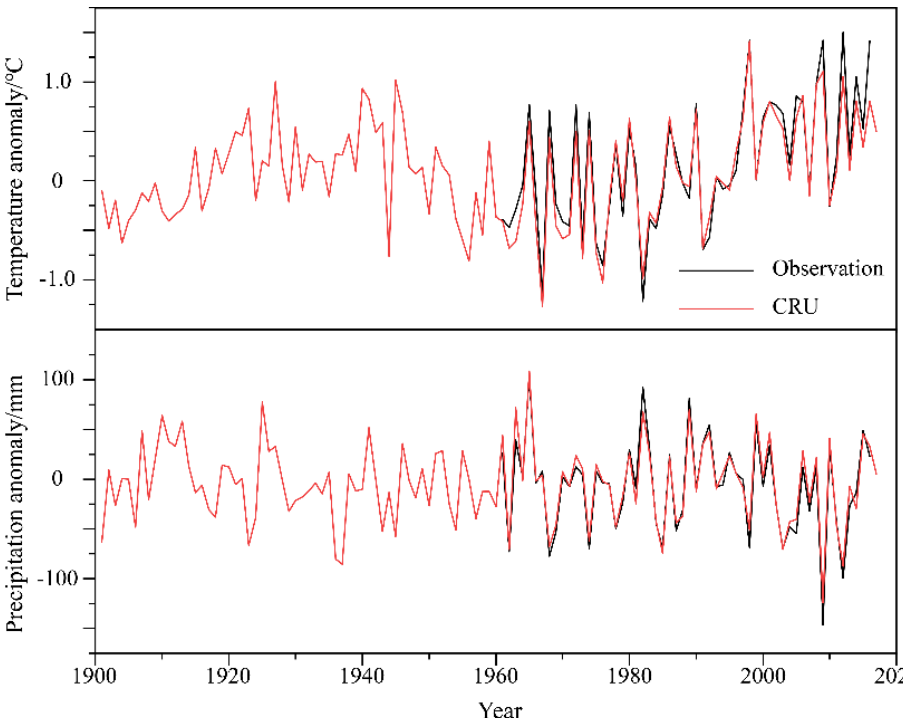
Figure 2. Temperature and precipitation anomalies for October–March relative to the 1971–2000 average in the study region.